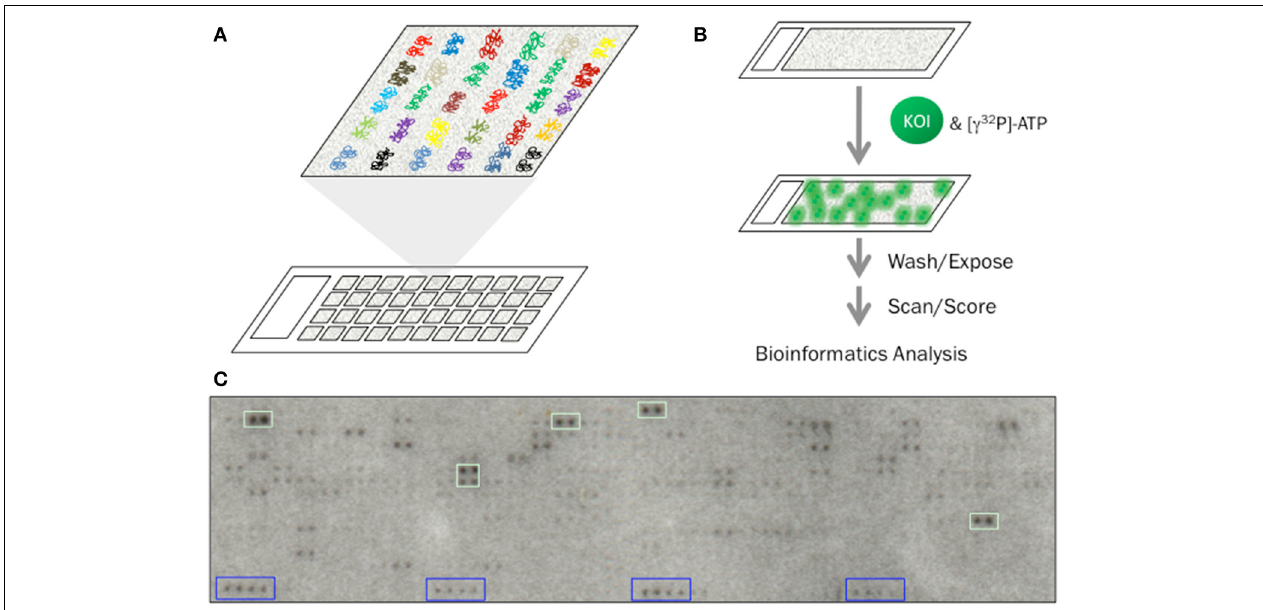
[ γ 32 P]-ATP, dried and exposed to high-resolution X-ray film. Autoradiograms are then scanned and scored before being subjected to bioinformatics analysis to identify those KSRs that are likely to occur inside the cell. (C) Autoradiogram from a typical phosphorylation assay. Duplicate spots that each exhibit a normalized signal intensity 3 SD above the mean (green boxes) are considered positive hits. General kinase substrates, such as histone H3 and H4, printed in each block (blue boxes) are used as landmarks to orient the grid during